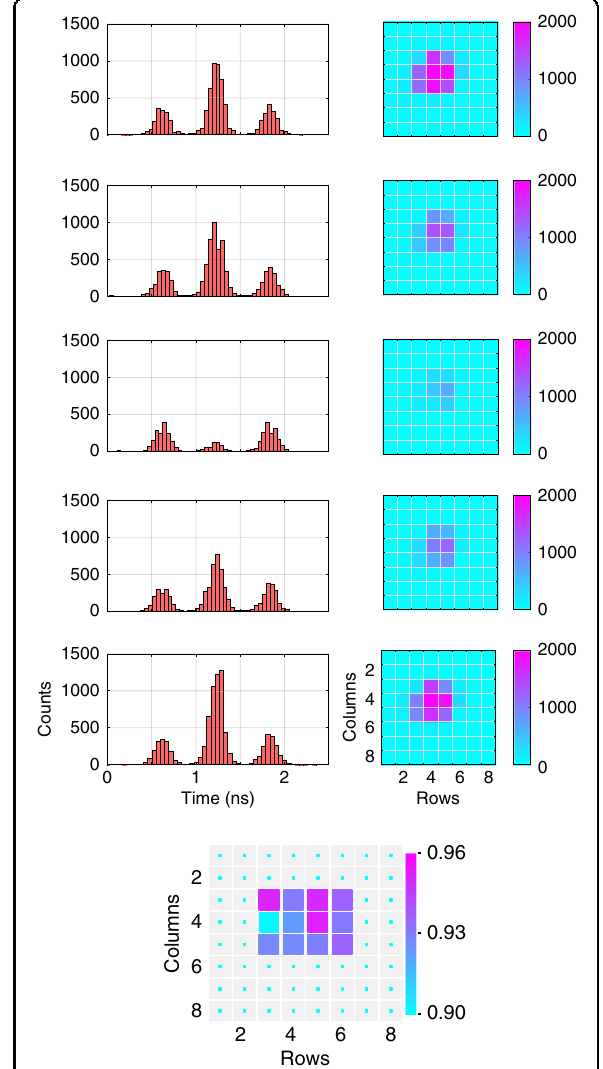
Fig. 2 Observed interference. Top left: histograms of the arrival times of photons at pixel number (4,4) (row 4, column 4). The three separate peaks correspond to photons coming via SS (right), SL or LS (middle), and LL (left) paths (see text for more detail). Five different phase-instances are shown. The visibility at this pixel – calculated by curve- fi tting – was V (4,4) ≈ 0.95. Top right: middle-peak intensity at the illuminated pixels at the corresponding phase-instances. Bottom: visibilities of the illuminated pixels calculated after fi tting the curves. The visibilities range from 0.9 to 0.95. Both the color and the size of the square marker in each pixel area are indicators of the visibility. Pixel number (1,1) was used as a trigger. The temporal precision was ≈ 120 ps